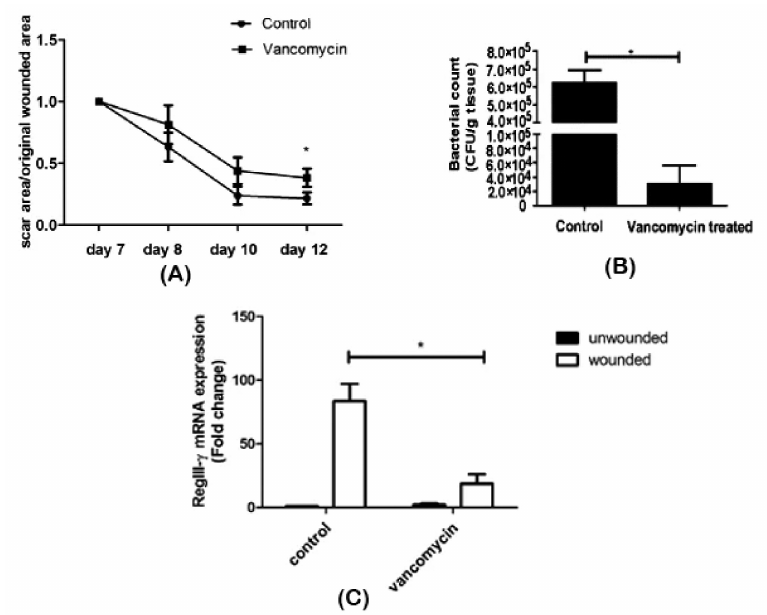
Figure 4. Impaired wound healing after vancomycin therapy. ( A ) Delayed wound repair was observed, ( B ) associated with reduced bacterial density and diversity and ( C ) decreased RegIII- γ expression in scar tissue. * p < 0.05. Adapted from Reference